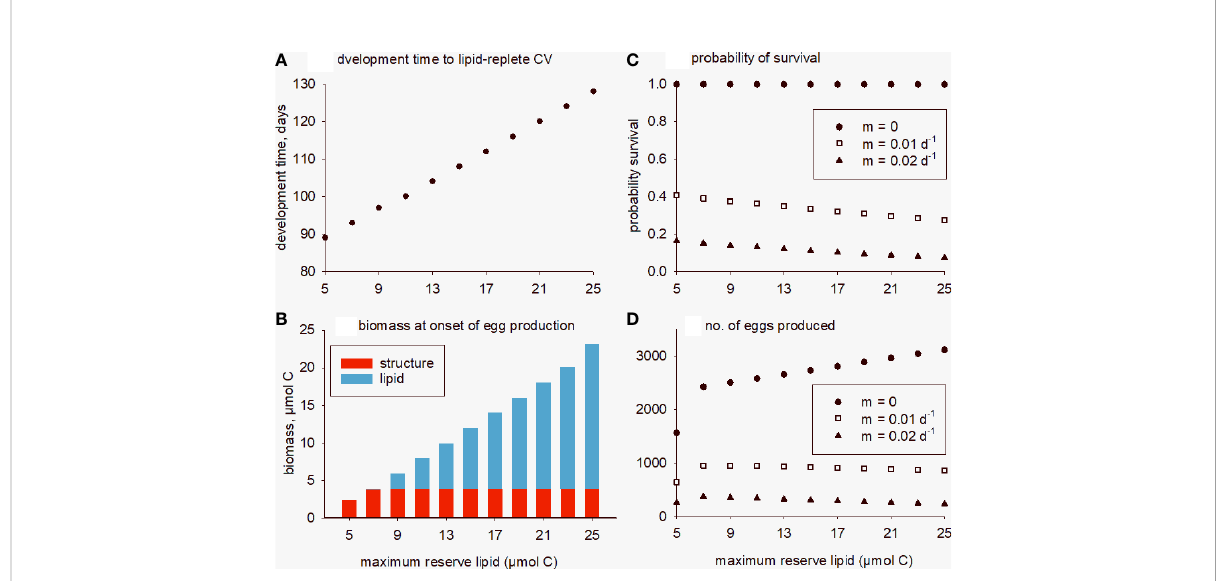
FIGURE 6 Model simulations in which lipid biomass at full-size copepodite stage CV (Z 3L ) was varied between 5 and 25 m mol C, noting that the default value is 9.4 (close to the third point/bar). (A) development time through Phases 1-3; (B) biomass (structure + lipid) remaining at the onset of egg production (Phase 6); (C) probability of individual survival based on development time and mortality rates of m Z = 0, 0.01, 0.02 per day; (D) average fecundity taking into account survival